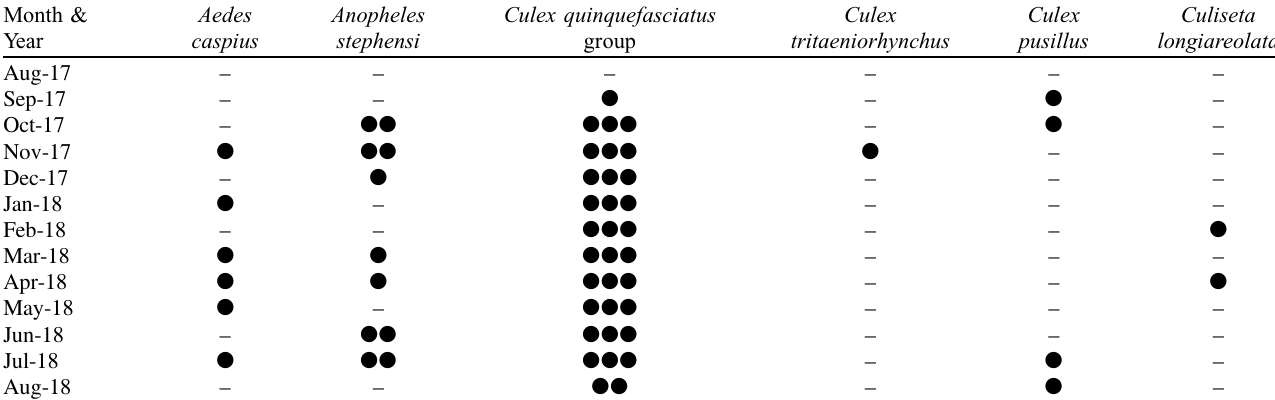
Table 3. Relative abundance and seasonality of mosquito species collected in the longitudinal adult monitoring, monthly, August 2017 – September 2018, according to one sample per month per site. One black dot = 1 – 10 individuals; Two black dots = 11 – 50 individuals; Three black dots = >50